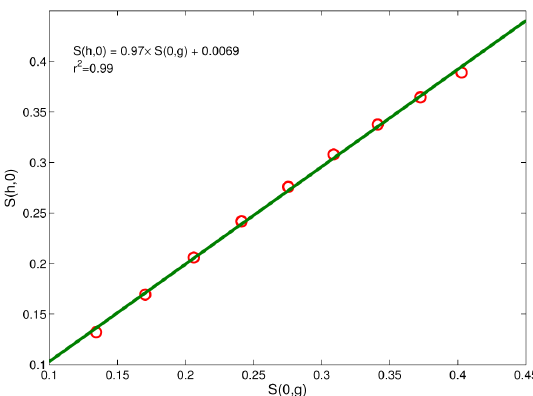
Fig. 9. Plot of the generalized correlation exponents S(h, 0 ) versus S( 0 ,g) This confirms the symmetry of the r(h,g) iso-values in the h – g